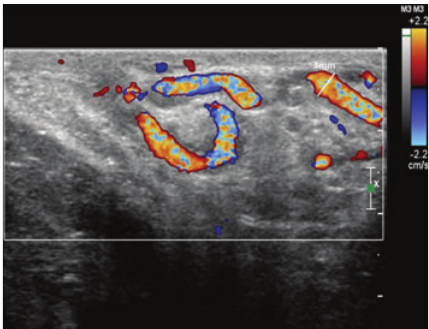
Figure 2: CT abdomen and pelvis with IV contrast, transverse image, displaying a large fatty lesion with associated soft tissue com- ponent (starred) in the right peritoneum anterior to the iliopsoas muscle. There is displacement of the bowel loops anteriorly and to the left.